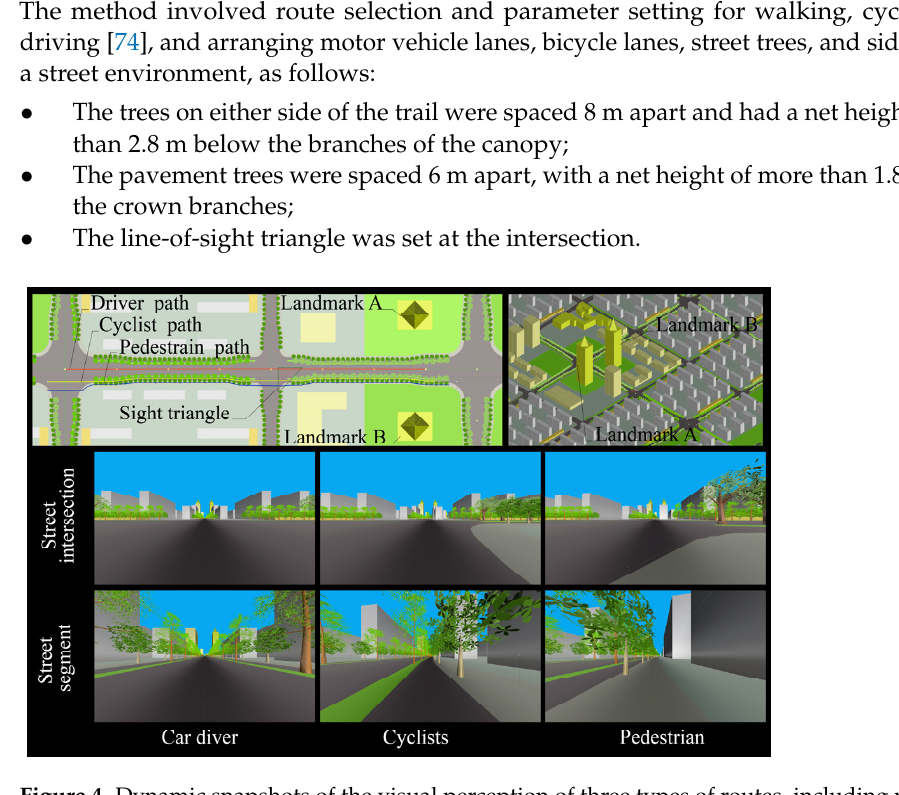
Figure 4. Dynamic snapshots of the visual perception of three types of routes, including pedestrian, bicycle, and driving, as simulated on the Rhino 3D software platform.